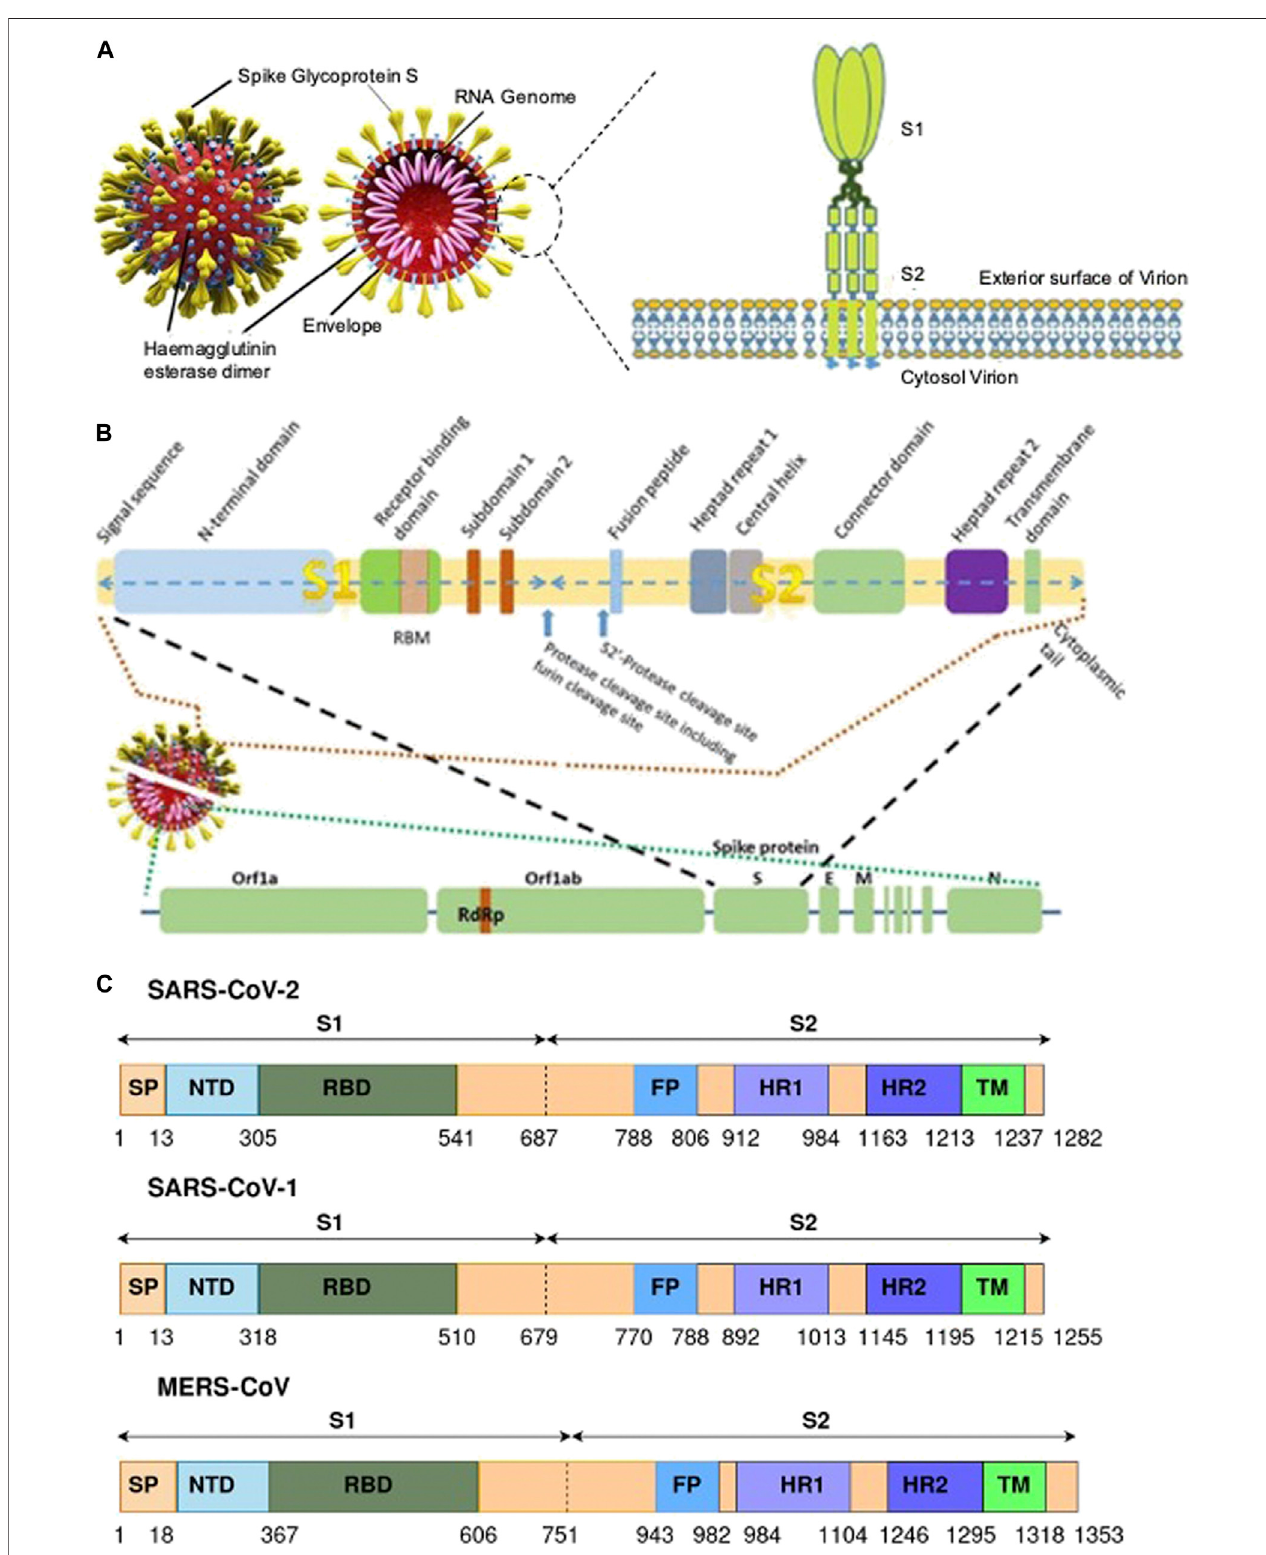
FIGURE 3 | (A) A representative of SARS CoV-2 and the S protein with their different binding domains S1 and S2 [(Pillay, 2020) Copyright ©2020 Publisher BMJ]; (B) the different region of the S protein of SARS CoV-2 [(Pillay, 2020) Copyright ©2020 Publisher BMJ]; and (C) genomic information of the S protein and the different binding domains for SARS-CoV-2, SARS-CoV-1, and MERS-CoV (Bahrami and Ferns, 2020).